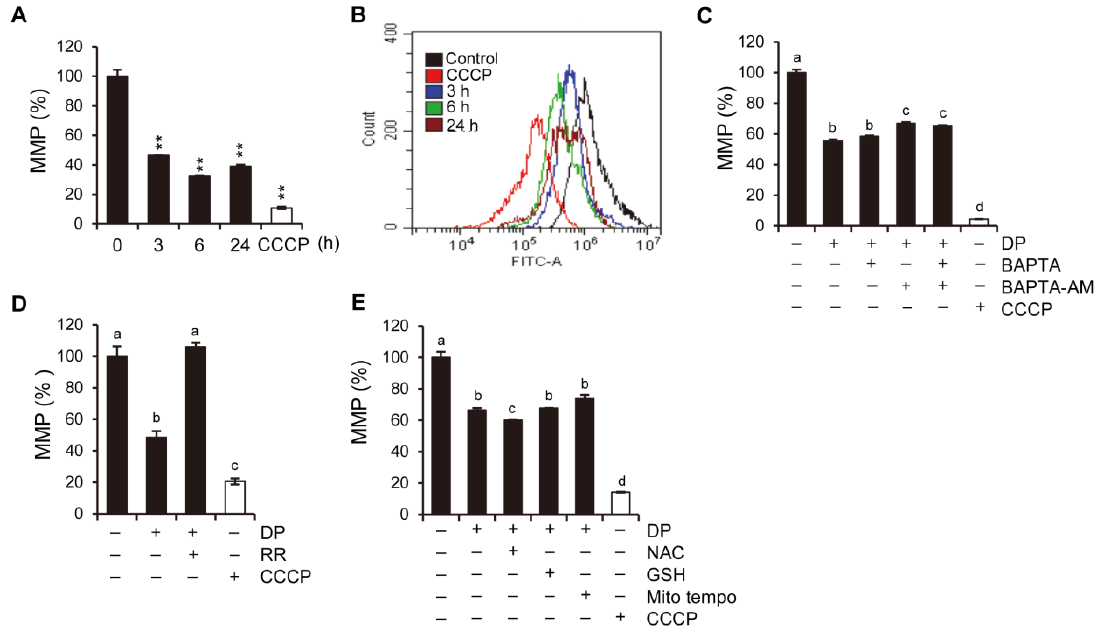
Figure 6. DP depletes mitochondrial membrane potential in A549 cells. ( A ) Carbonyl cyanide 3- chlorophenylhydrazone (CCCP; 50 µM) was used as a positive control. ( B ) A549 cells were treated with 40 µM DP for the indicated time, then stained with 40 nM DiOC6(3) for 30 min at 37 °C and analyzed via flow cytometry. ( C – E ) A549 cells were cotreated or pretreated with the indicated Ca 2+ chelator, RR, and NAC and GSH for 1 h and further treated with 40 µM DP for 6 h. MMP was assessed using DiOC6(3). All data are expressed as the mean ± SD obtained from at least three independent experiments. Statistical differences were analyzed by two-way ANOVA with Tukey’s multiple comparisons test and presented as p < 0.01 (**) compared with the control. Different lowercase letters above the bar graph indicate significant statistical differences ( p < 0.05).